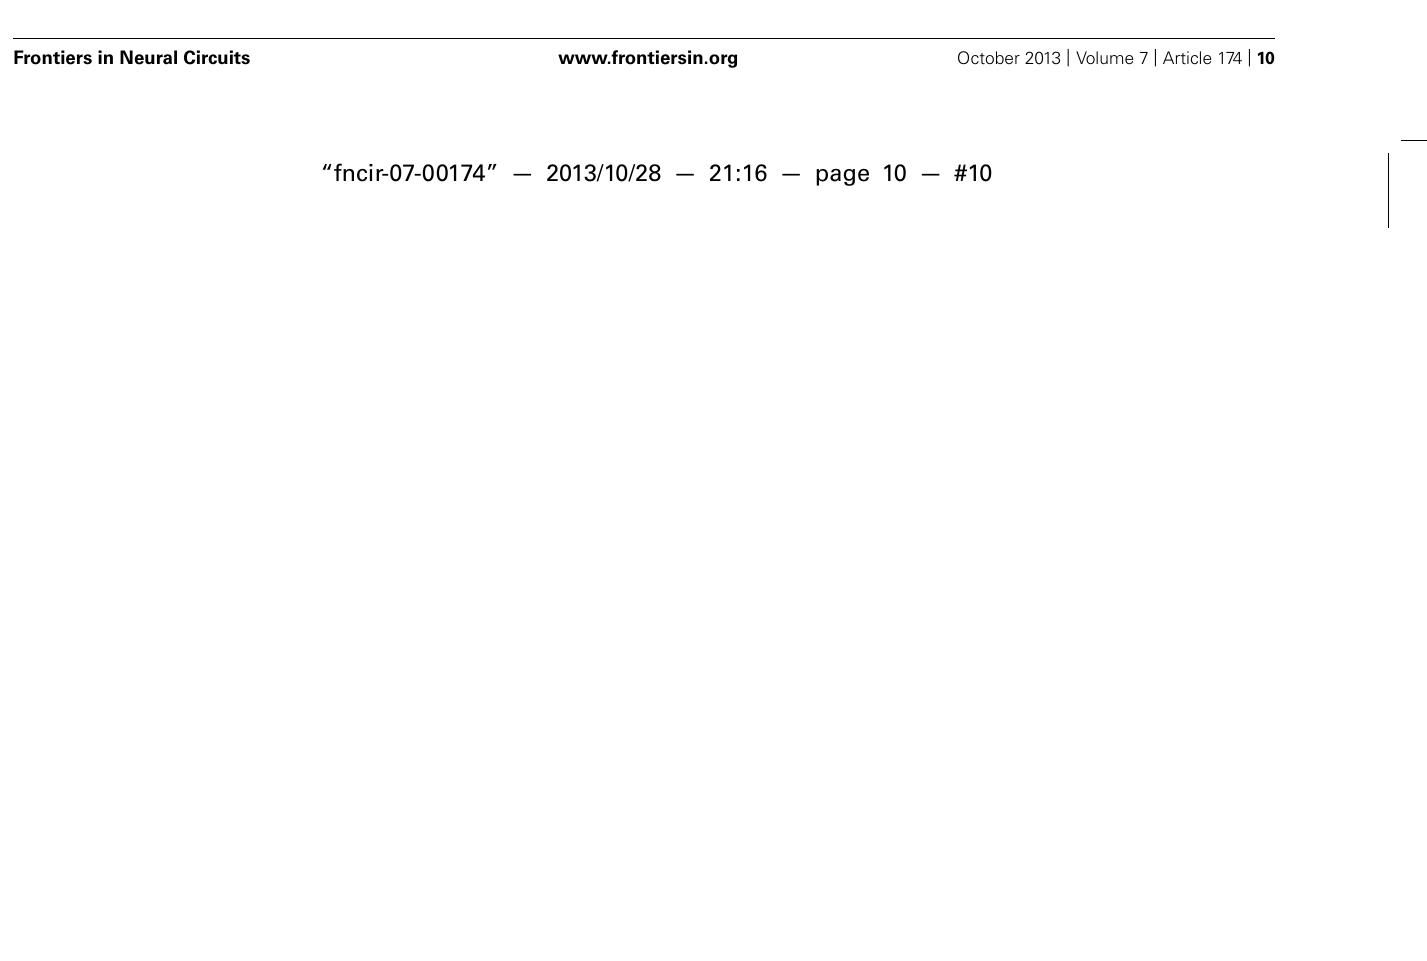
linear fits (black lines) of the rising and falling limbs of RIF M ( E ) and RIF M for Neuron 1 in (B) . Rising limb: RIF M , r 2 = 0.90285; slope, 4.12821 spikes/s/dB SPL; RIF M ( E ) ; r 2 = 0.92772; slope, 8.2253; falling limb: RIF M , r 2 = 0.88935; slope, − 3.30769; RIF M ( E ) , r 2 = 0.98401; slope, − 6.3333. Right: population averages of tuned widths.Tuned widths were measured at half the peak height of normalized functions. 14 cells. Mean and